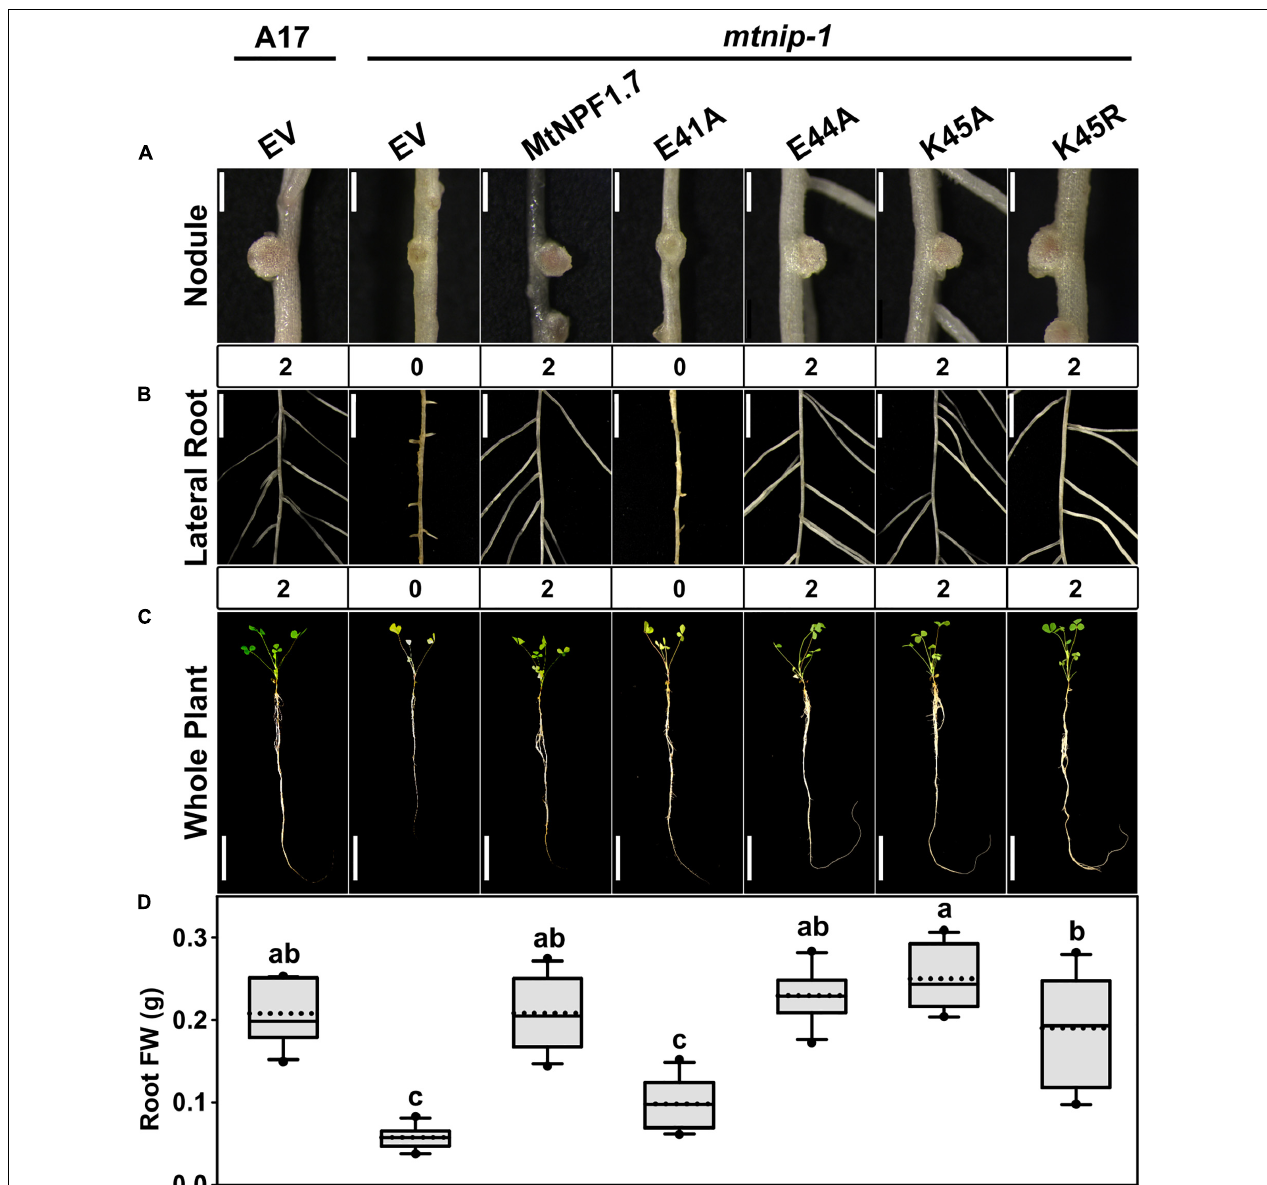
FIGURE 2 | Results of in planta complementation for the ExxE(R/K) motif mutants. Images showing (A) the nodules, (B) the lateral roots and (C) the whole plants of (from left to right) A17 plant roots transformed with the pMU06 empty vector (EV) and mtnip-1 plant transformed with the EV, MtNPF1.7_wt (pYCY400), _E41A (pYCY403), _E44A (pYCY404), _K45A (pYCY405), or _K45R (pYCY406). Nodules and lateral roots were evaluated by complementation levels of defective phenotypes shown below each image: 0 = no complementation, 1 = partial complementation, 2 = full complementation. (A) Bars = 1 mm. (B) Bars = 5 mm. (C) Bars = 5 cm. (D) Plots of root fresh weight from ten independent transgenic plants ( n = 10). Data are shown as box plots. The lower and upper boundaries of the box indicate the 25th and 75th percentiles, respectively, with the median and mean marked as solid and dotted lines, respectively. The ends of lower and upper whiskers indicate the minimum and maximum values. Outliers are shown as dots. The letters above each box indicate the significant differences analyzed by ANOVA and the post hoc Tukey’s HSD (honestly significant difference) test ( P < 0.05). Only the E41A mutant failed to complement the mtnip-1 phenotype, while E44A, K45A and K45R restored the wild type